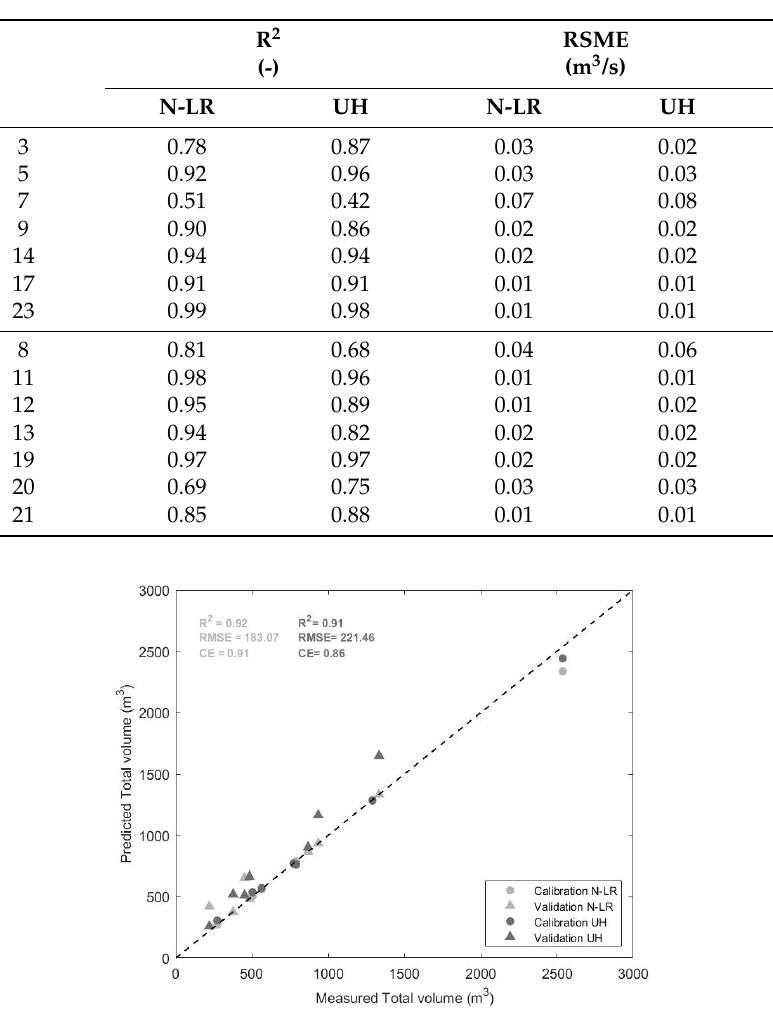
Figure 7. Comparison plot between measured and predicted peak flow Q Max , for N-LR (light grey) and UH (dark grey) model in either calibration (solid circle) or validation (solid triangle) step. Finally, in Figure 8, the comparison between the measured and the predicted time to peak is shown. From the performance indices and the alignment of the dots along the bisector, it is evident that both models, either in calibration or in validation, provide a very accurate estimation of the time in which the peak flow occurs, with an average error of just a few minutes (RMSE = 2.95 min for N-LR and RMSE = 3.9 min for the UH). The R 2 is excellent for both models (R 2 = 0.99).